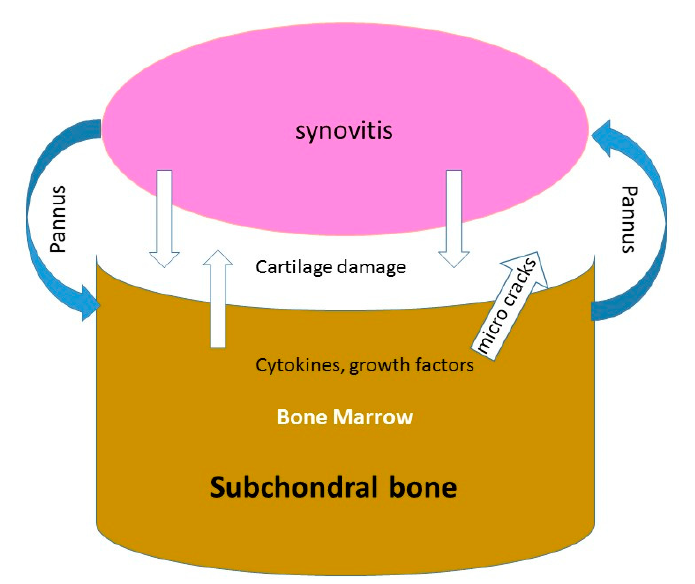
Figure 5. Schematic illustration of the interaction between synovitis, cartilage and subchondral bone in OA.